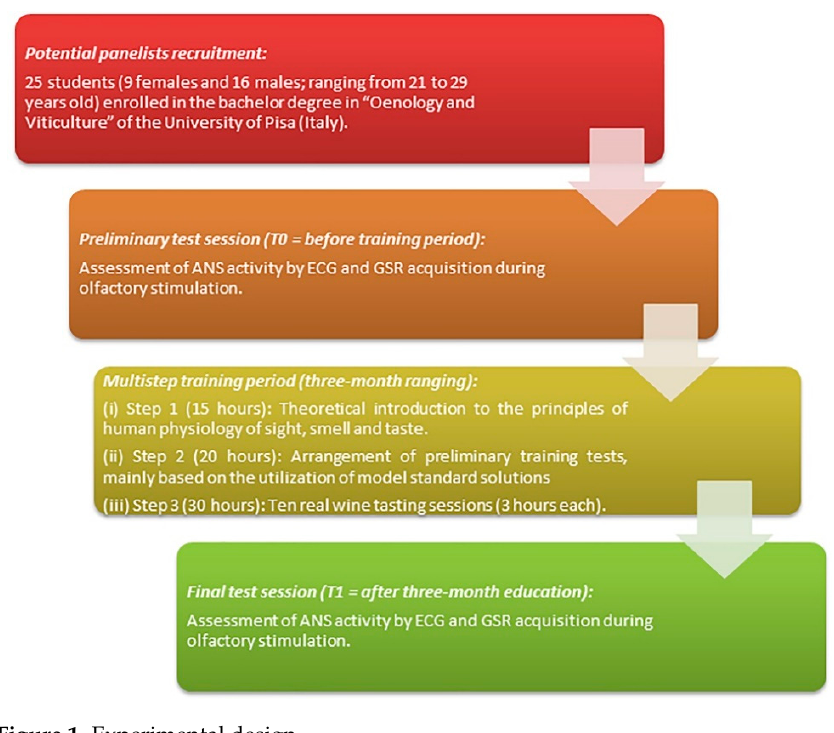
Figure 1. Experimental design. Table 1. Odorous solutions used for the